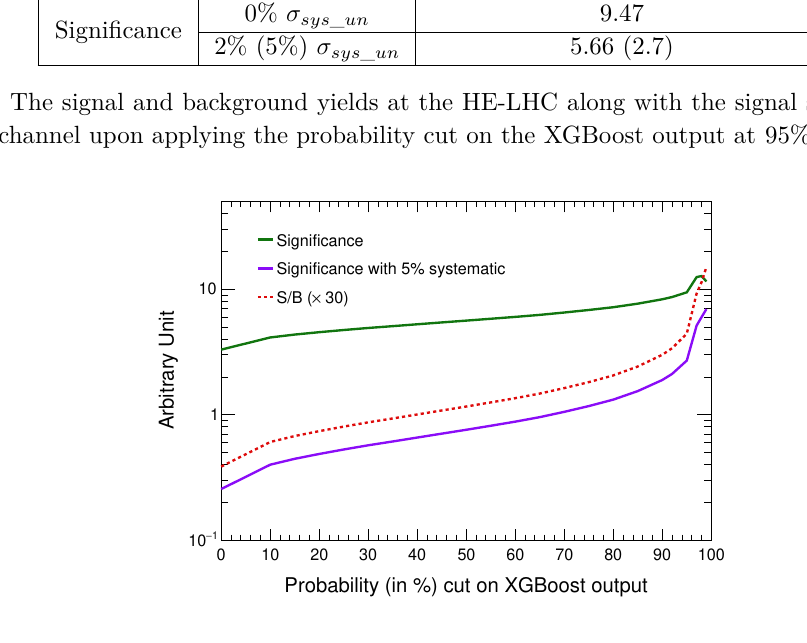
Figure 2 . The variation of significance (with ( 5% ) and without systematic uncertainty) and S/B is shown as a function of the probability cut on the XGBoost output for the b ¯ bγγ